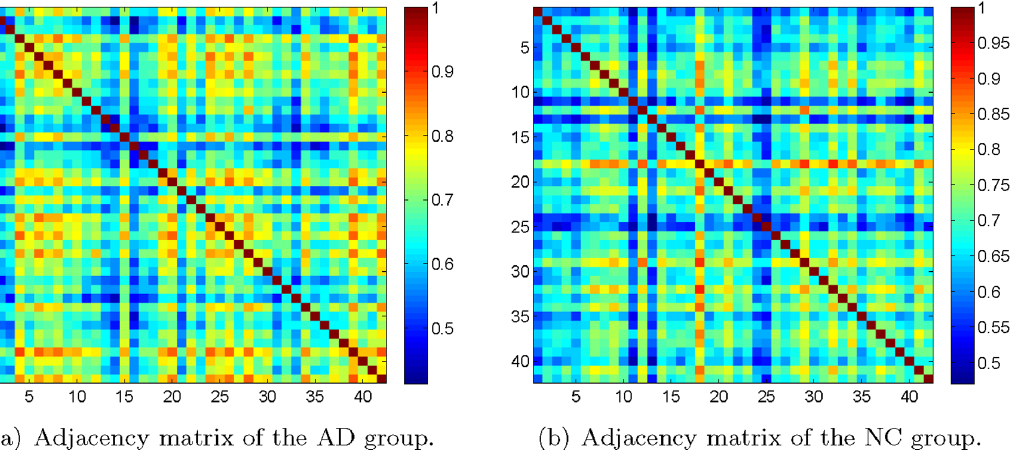
Fig 9. Adjacency matrices obtained by NMI. Adjacency matrices obtained by computing the normalized mutual information between observations of every pair of brain regions, for the AD group (left panel) and the NC group (right panel),